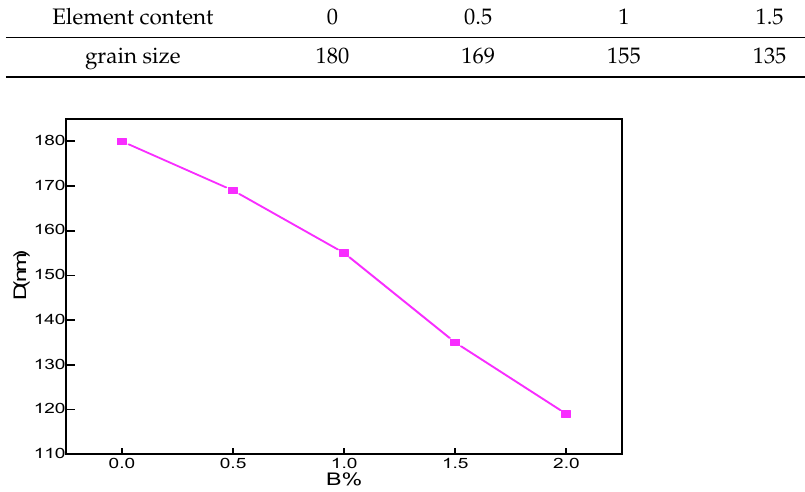
Figure 3. Grain size diagram of different nitrogen content. Table 3. Austenite grain size with different boron content (nm).